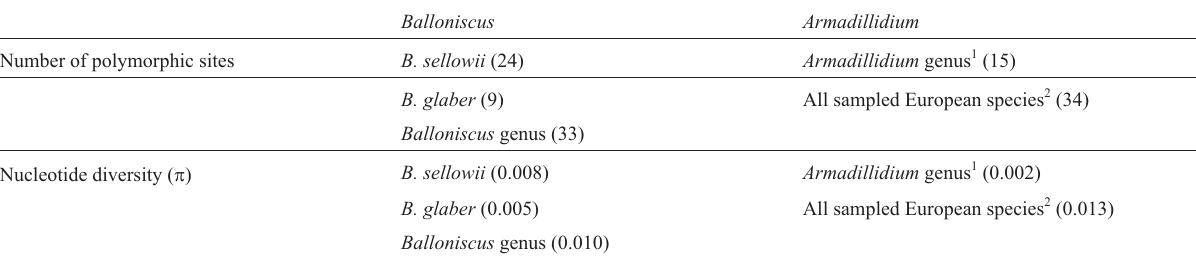
Table 2 - Wolbachia diversity and polymorphism of 16S rDNA in Balloniscus species and European